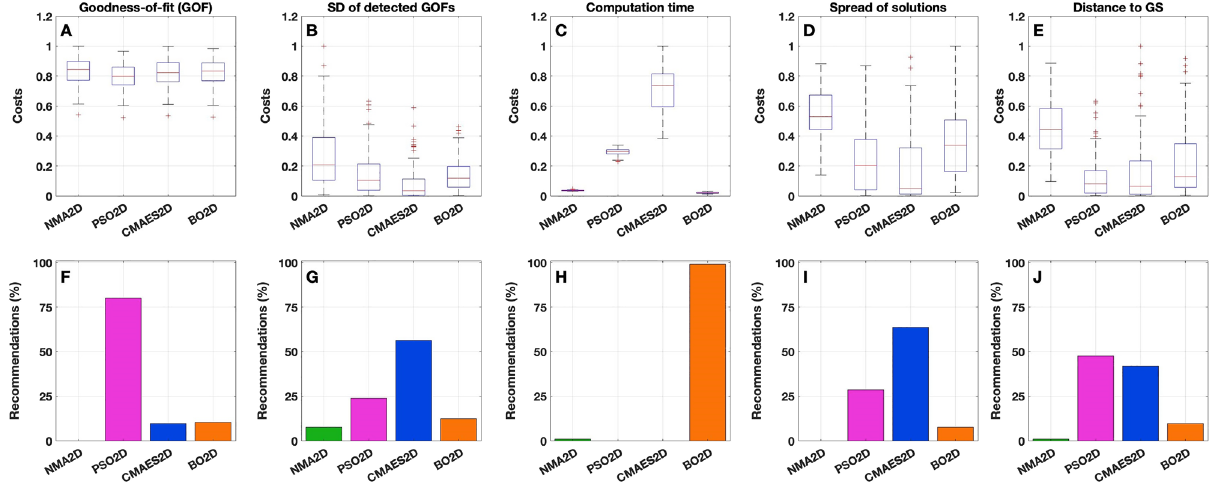
Figure 6. Components of the cost function (cid:31) cost for the 2Dim case. ( A – E ) Boxplots illustrate the distributions of the values of the components indicated in the titles (see text for details). All values were normalized by the respective maxima (given as one quantity over all algorithms for a given component). The individual cost values are shown on the vertical axes while the corresponding algorithms (NMA2D, PSO2D, CMAES2D and BO2D) are indicated on the horizontal axes. ( F – J ) For each cost component, histograms show the relative number of recommendations obtained by a given optimization algorithm across all subjects. This quantity was calculated by counting the number of subjects for which the respective algorithm is considered recommendable , i.e. where it provides the lowest costs among all four investigated methods. The absolute value was then divided by the total cohort size of 105 subjects. As before, the methods are listed on the horizontal axes. On the vertical axes, it is indicated for which fraction of subjects a particular method is recommended. The figure was created with MATLAB R2018a (www. mathw orks. com).